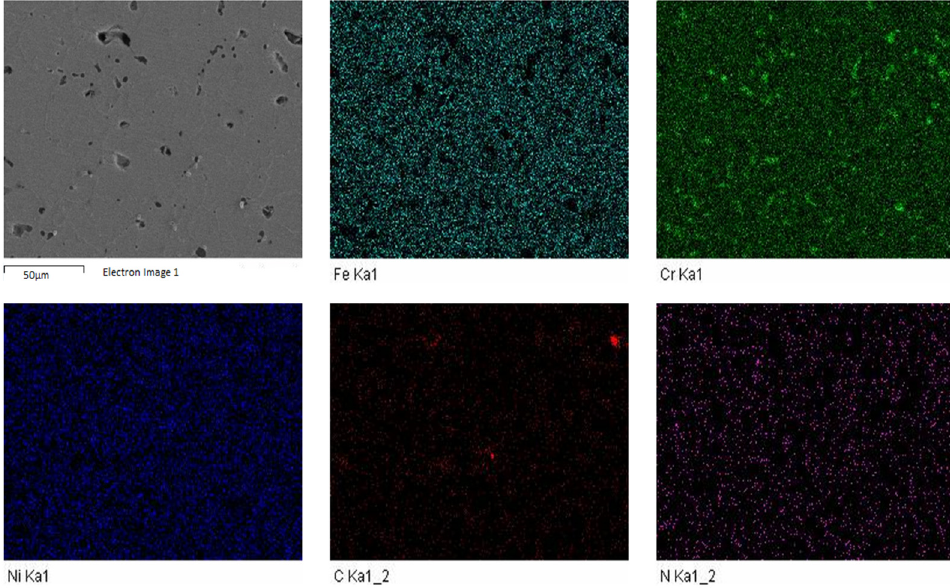
Figure 6. FESEM-EDS elemental maps for sample sintered at 8 h dwell time.